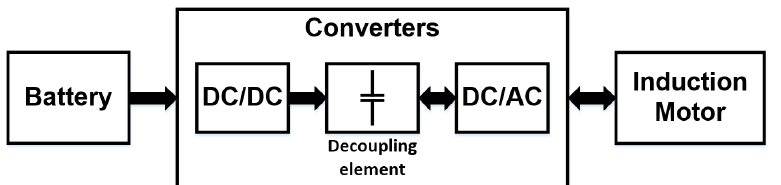
Figure 1. Electric vehicle propulsion system.